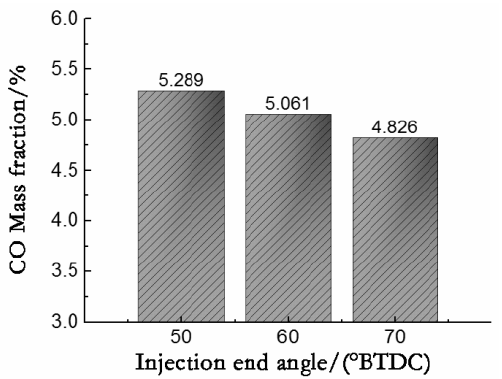
Figure 17. CO data corresponding to different injection end angles.